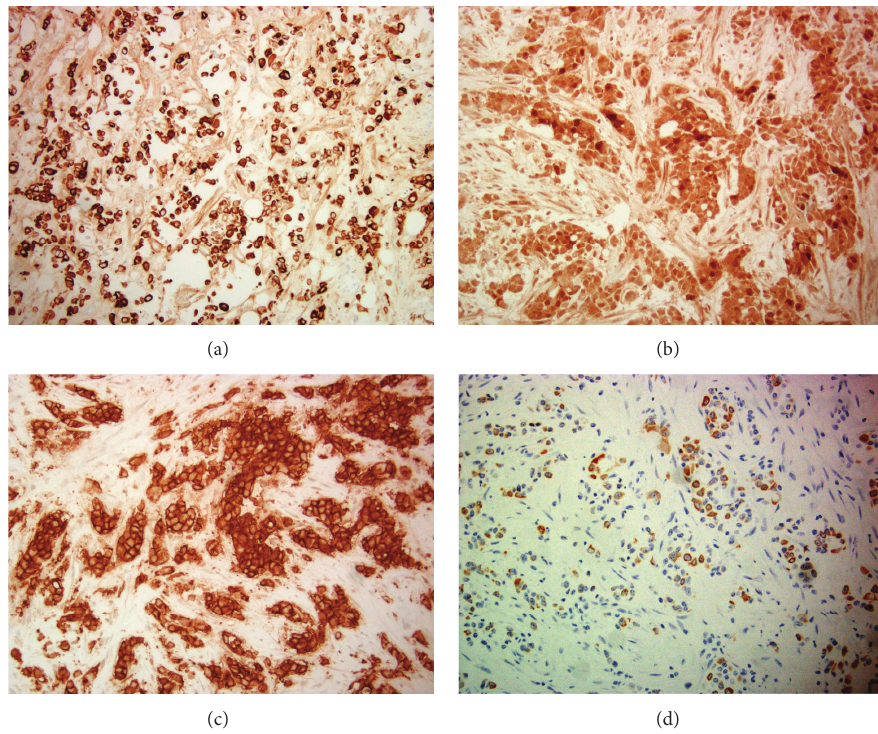
Figure 3: ((a), (b), (c), and (d)) Immunohistochemistry showing positive staining for CK 7, calretinin, MOC31, and CK 20 (focal).